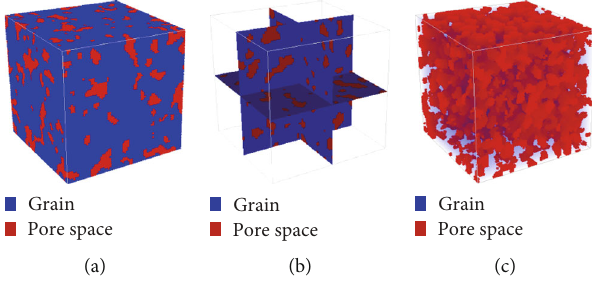
Figure 7: A reconstructed image using VAE: (a) exterior; (b) cross-sections ( X = 32 , Y = 32 , and Z = 32 ); (c) pore space.